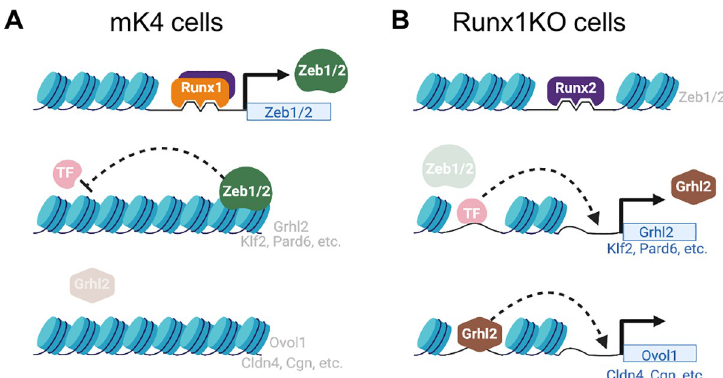
Fig 6. Model of Transcription Factor Network Perturbation by Runx1-Deficiency. A) In control mK4 cells, Runx1 induces the transcriptional repressors Zeb1 and Zeb2 that inhibit other transcriptional activators such as Grhl2, resulting in inhibition of downstream Grhl2 target genes. B) Runx1KO cells lose expression of Zeb1 and Zeb2, which derepresses their targets including Grhl2 and Klf2, which in turn leads to upregulation of their downstream targets such as Ovol1, Cldn4, and Cgn. Figure was created using BioRender.com.